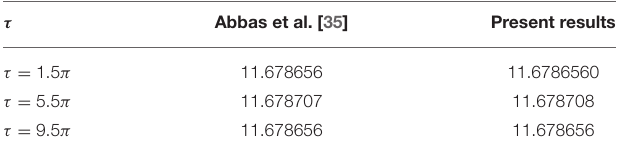
TABLE 1 | Comparison of f ξξ ( 0, τ ) for τ with Abbas et al. [35] when S (cid:127) 12, Ŵ 0, and K 0. = = =